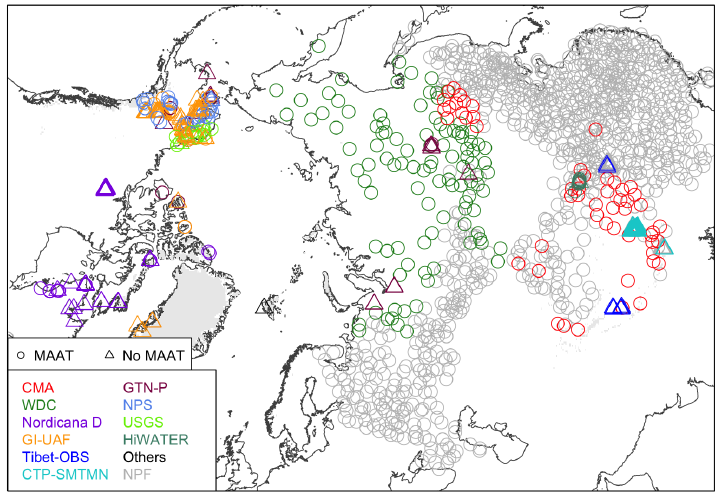
Figure B1. Distribution of soil temperature stations. Stations in permafrost regions are in color, while the gray ones are non-permafrost (NPF) stations. Stations in a circle have additional air temperature observations; stations marked by a triangle do